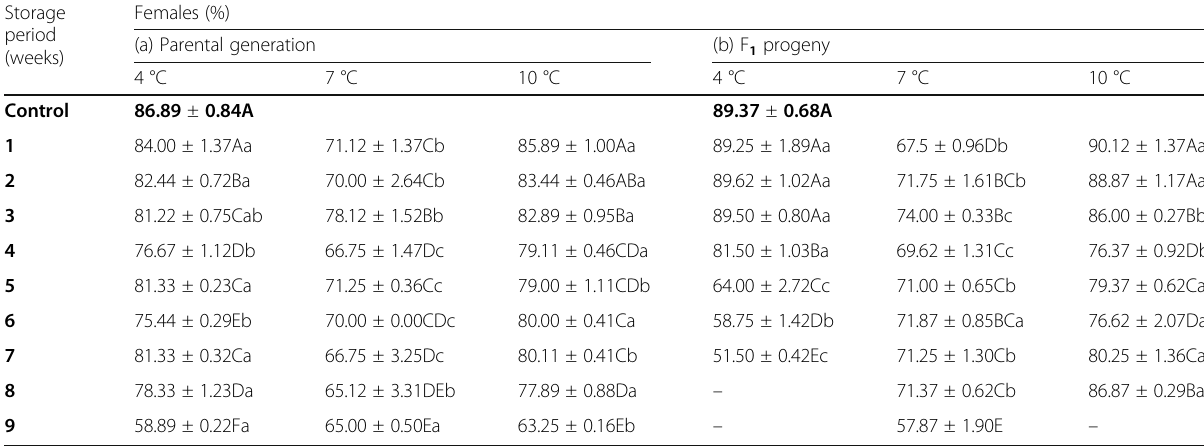
Means ± SE sharing the same capital letters in the same columns, and same small letters in the rows are statistically insignificant ( P ≥